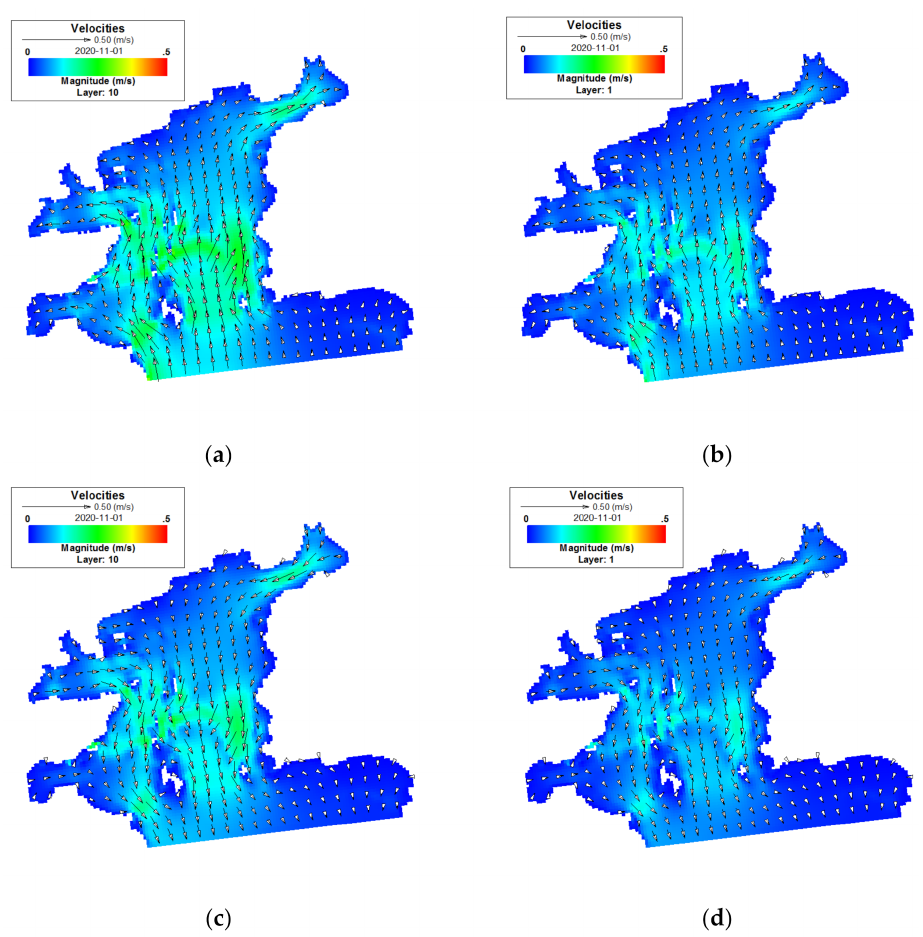
Figure 5. Tidal current field in Daya Bay: velocity distributions of ( a ) surface flow and ( b ) bottom flow during fastest high tide; velocity distribution of ( c ) surface flow and ( d ) bottom flow during fastest low